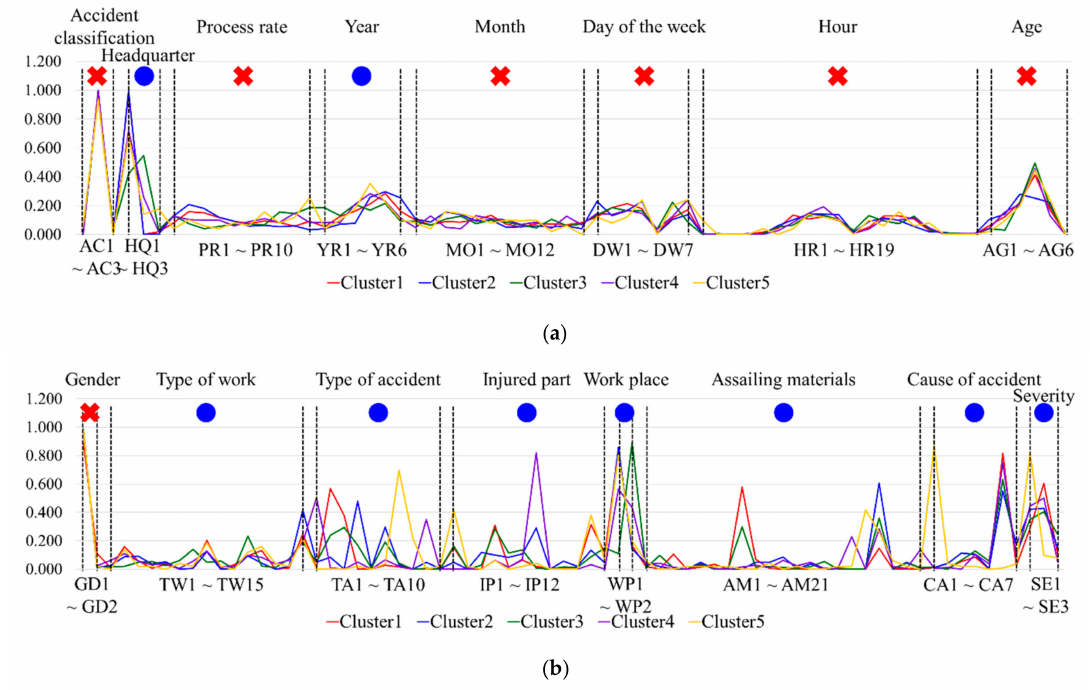
Figure 2. Latent Class Cluster Analysis (LCCA) selection of major variables for construction accident data. ( a ) Variables 1–8; ( b ) Variables